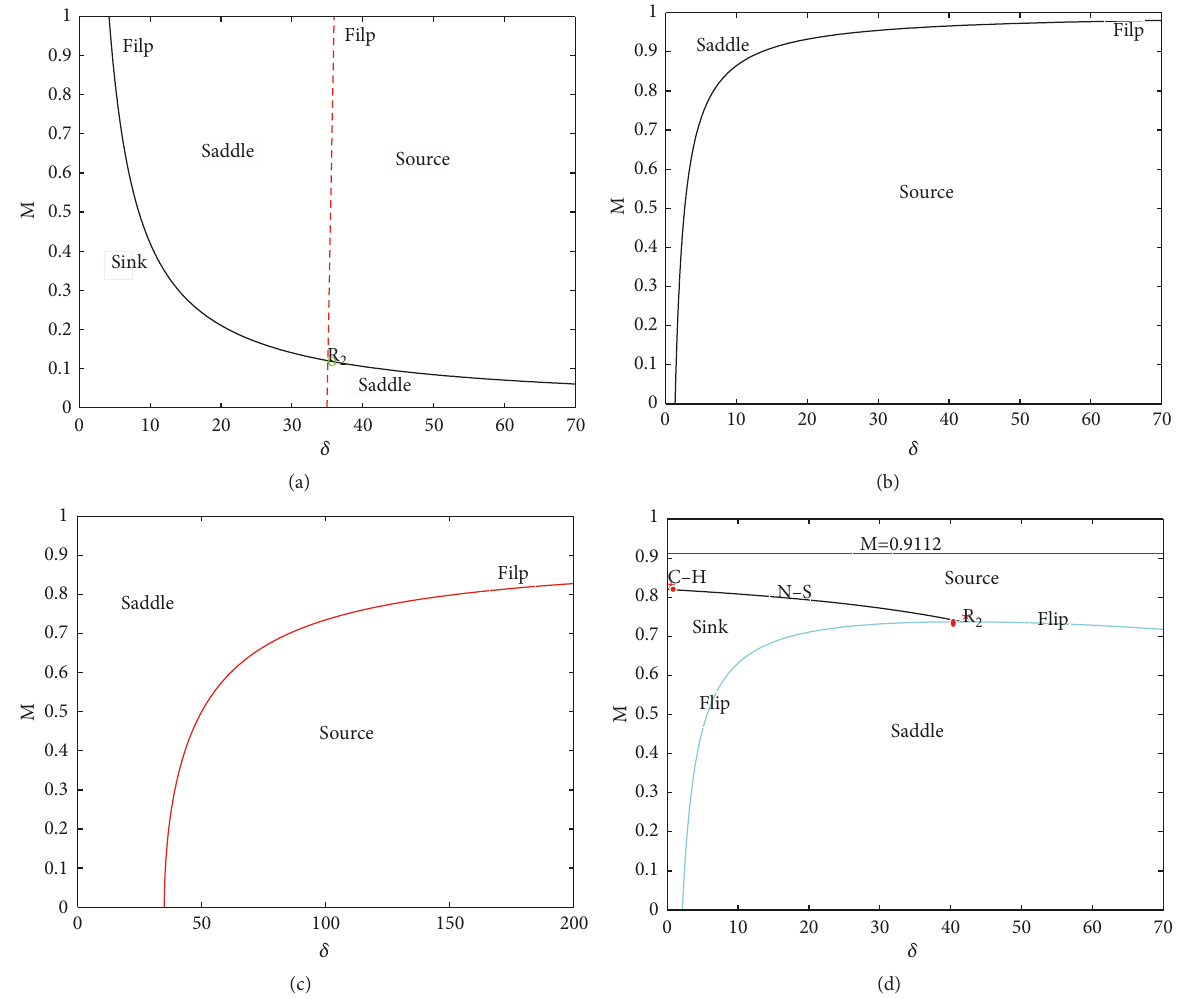
Figure 1: The stability of equilibrium point in 𝛿 - 𝑀 plane. (a) The stability of (0, 0) and the two curves denote the flip bifurcation manifolds and divide the 𝛿 - 𝑀 plane into four regions with different stability of (0, 0) . The intersections 𝑅 2 denote the strong 1:2 resonance. (b) The stability of (1, 0) . (c) The stability of (𝑀,0) . (d) The stability of (𝐶,𝐿) . (𝐶,𝐿) exists when 𝑀 values are underneath 𝑀 = 0.9112 curve. N-S curve denotes the Neimark-Sacker manifold. The N-S curve and flip curve divide the 𝛿 - 𝑀 plane into three regions with different stability of (𝐶,𝐿)